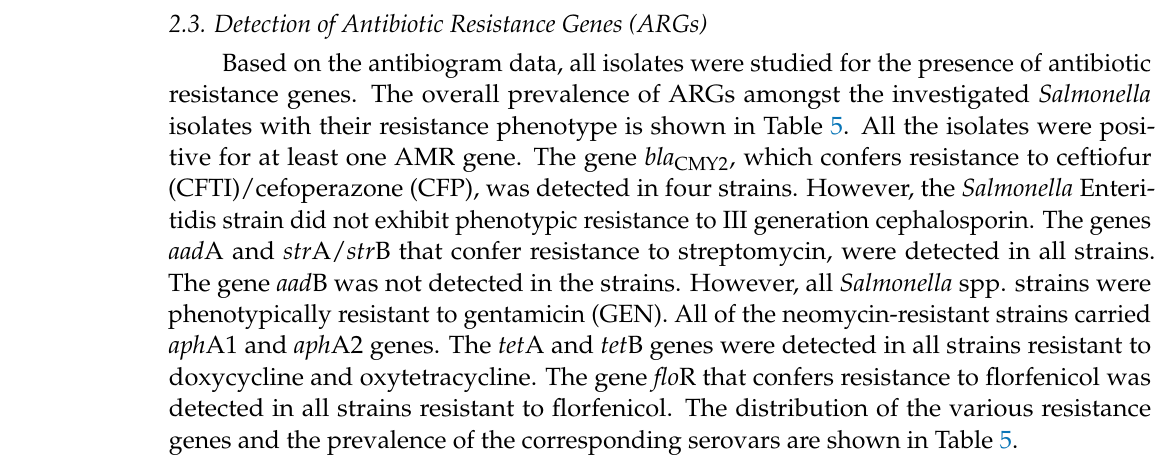
Table 5. Distribution of resistance genes amongst Salmonella